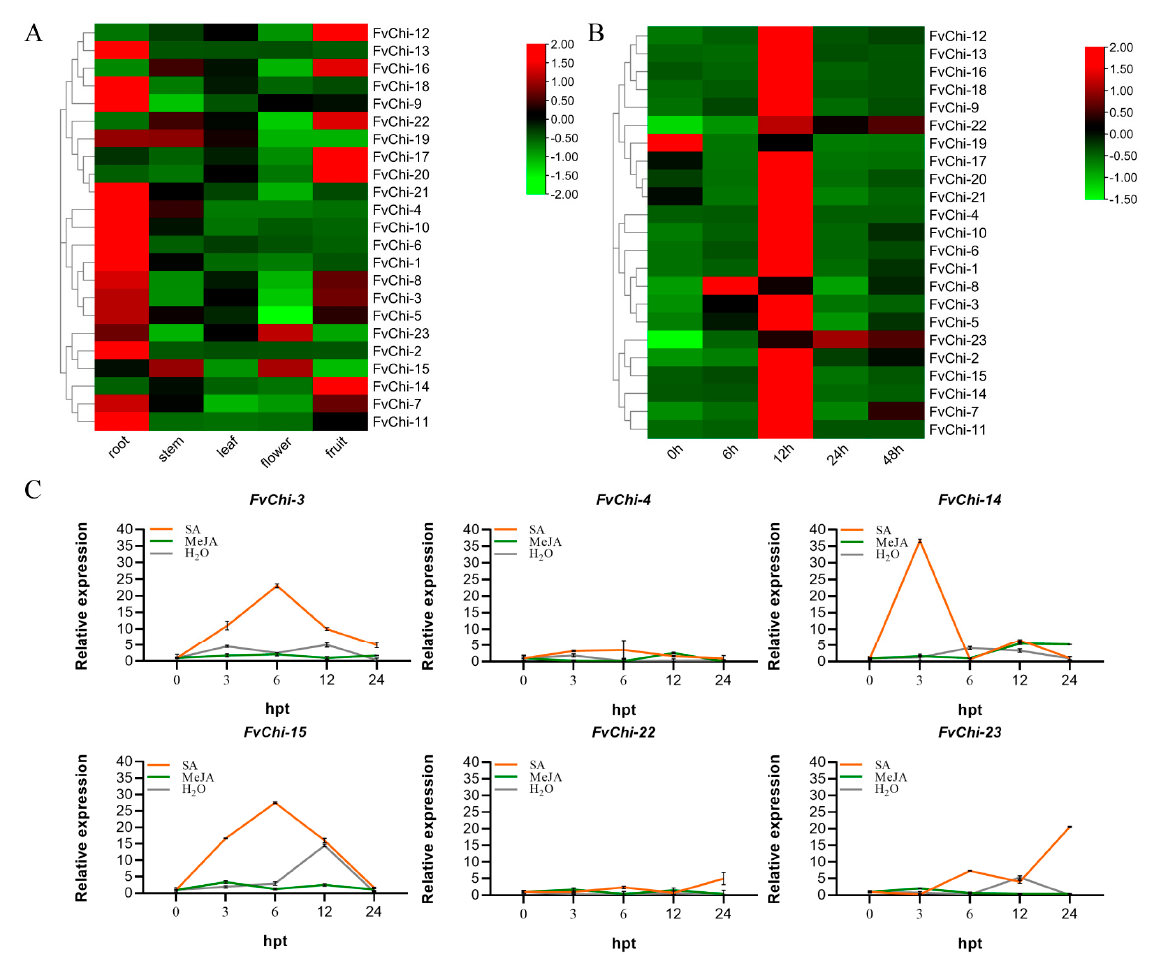
Figure 6. FvChi gene expression profiles in different tissue/organs and response to C. gloeosporioides inoculation and hormones treatment by qRT-PCR. ( A ) FvChi gene expression in different tissue/organs including root, stem, leaf, flower, and fruit. ( B ) FvChi gene expression profiles in response to C. gloeosporioides inoculation. ( C ) FvChi gene expression profiles in response to SA, MeJA, and water treatments. Red and green color scale denotes high and low expression levels, respectively. Error bars indicate the standard deviation (SD) of three biological replicates.